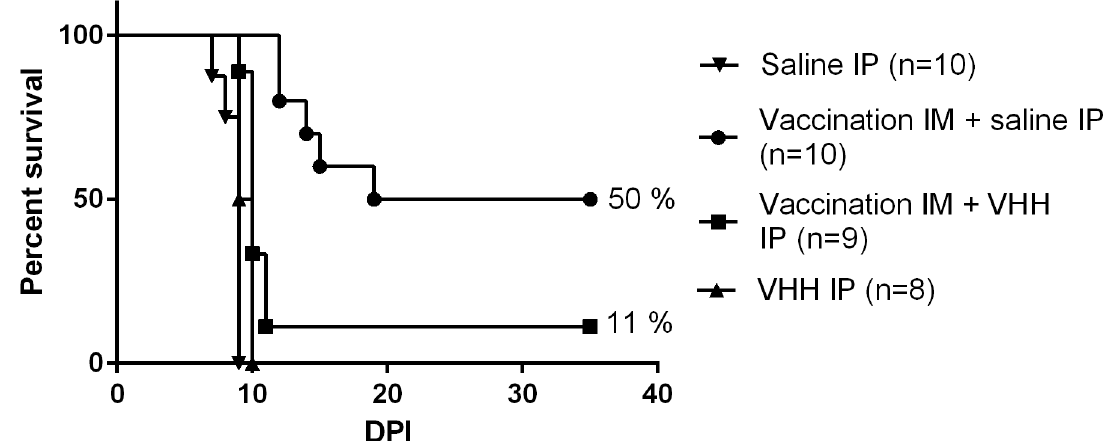
Fig 2. Effect of pre-exposure vaccination on survival in rabies mouse model. Mice received intramuscular (IM) vaccination at day -28 alone or in conjunction with intraperitoneal (IP) anti-rabies VHH (Rab-E8-H7-ALB11, 1.5 mg/mouse). Vaccinated mice received a booster vaccination at day -25. Control groups received a single dose of anti-rabies VHH or mock treatment (Saline) at day -28. Preventive vaccination could protect 50% of the animals from lethal infection whereas mice receiving vaccine simultaneously with anti-rabies VHH, or VHH alone, were significantly less protected from lethal disease (p < 0.001).